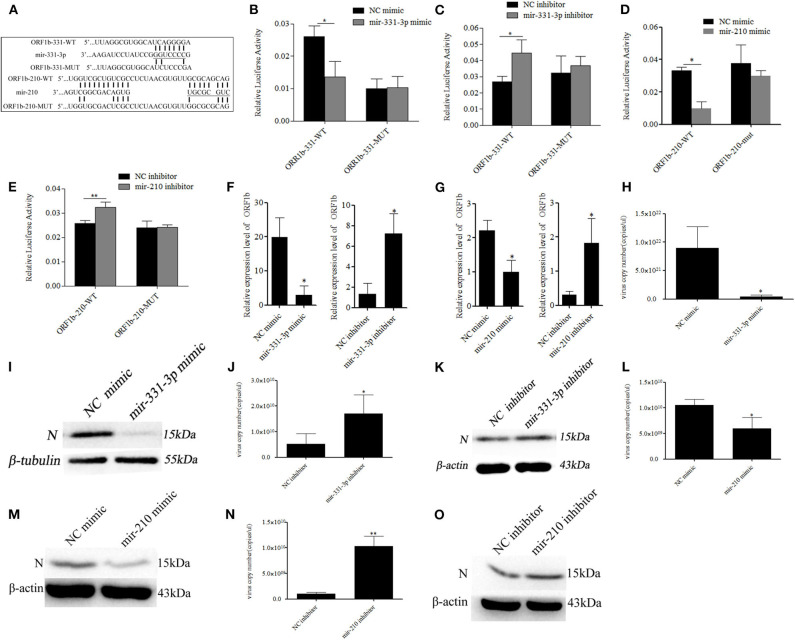
Mir-331-3p and mir-210 inhibit PRRSV-2 replication. Bioinformatical predication showed that ORF1b was a putative target gene of mir-331-3p and mir-210 (A). The dual luciferase reporter assay was verify the bind of mir-331-3p and ORF1b in cells co-transfected with ORF1b-331-WT/ORF1b-331-MUT and mir-331-3p mimics (B) or mir-331-3p inhibitor (C). The dual luciferase reporter assay was used to verify the bind of mir-210 and ORF1b in cells co-transfected with ORF1b-210-WT/ORF1b-210-MUT and mir-210 mimics (D) or mir-210 inhibitor (E). ORF1b expression was quantitatively analyzed in Marc-145 cells infected with PRRSV-2 after transfection with mimics/inhibitor of mir-331-3p (F) or mir-210 (G). Marc-145 cells were transfected separately with mir-331-3p mimics and mir-331-3p inhibitor, and then infected with PRRSV-2 (MOI = 0.1). The cells were harvested at 36 h post PRRSV-2 infection, and qRT-PCR (H,J), and western blot (I,K) was carried out to detect PRRSV-2 replication. Meanwhile, Marc-145 cells were transfected separately with mir-210 mimics and mir-210 inhibitor, and then infected with PRRSV-2 (MOI = 0.1). The cells were harvested at 36 h post PRRSV-2 infection, and qRT-PCR (L,N) and western blot (M,O) was carried out to detect PRRSV-2 replication. All values represent the mean ± s.d. of three independent experiments.*p < 0.05, **p < 0.01.